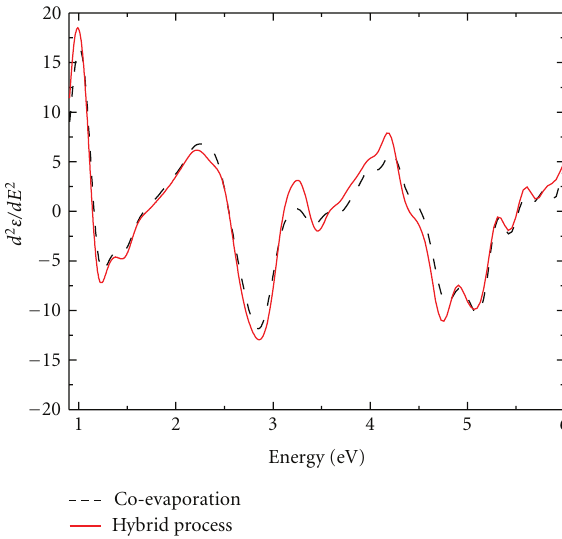
Figure 3: Second derivatives of the imaginary parts of the dielectric functions ( ε 2 ) of 60nm Cu(In,Ga)Se 2 films obtained by hybrid (solid line) and coevaporation processes (dotted